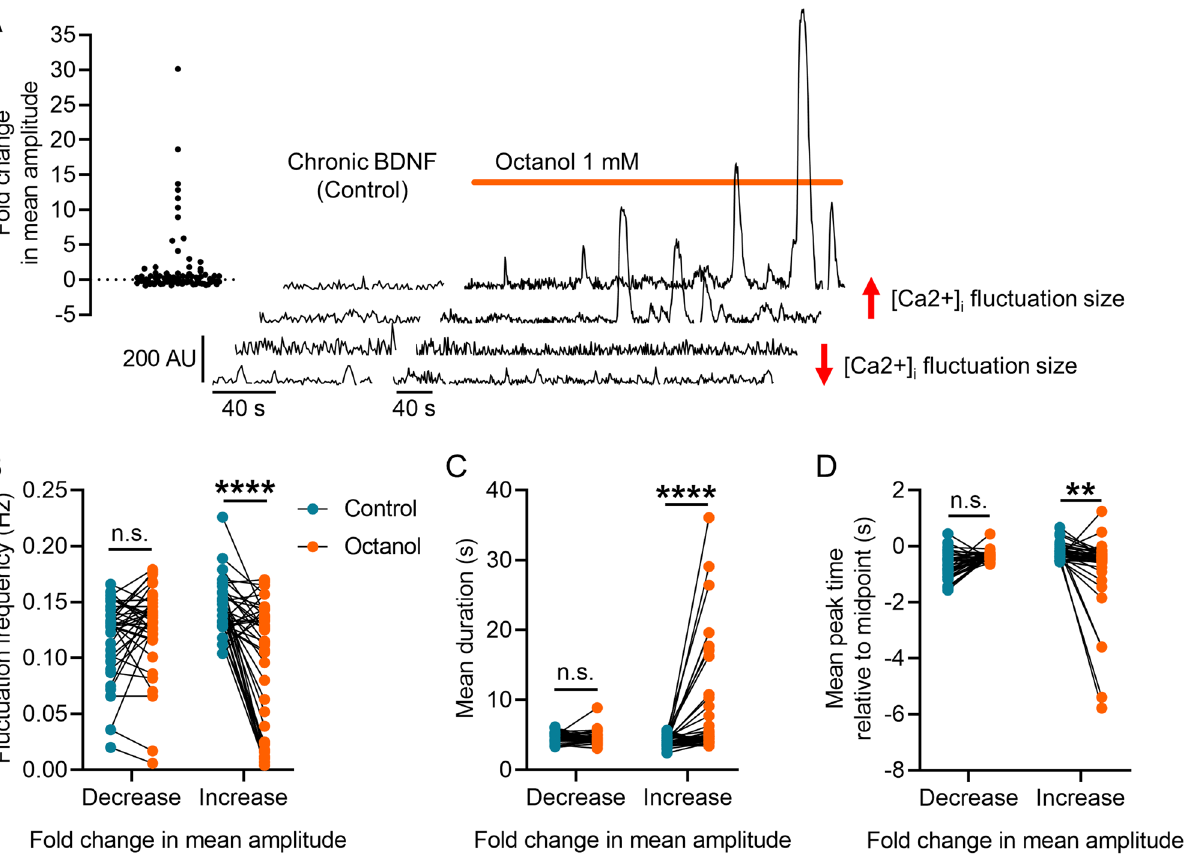
Figure 2. Effect of gap junction blocker octanol on BDNF-induced [Ca 2+ ] I fluctuations. ( A )